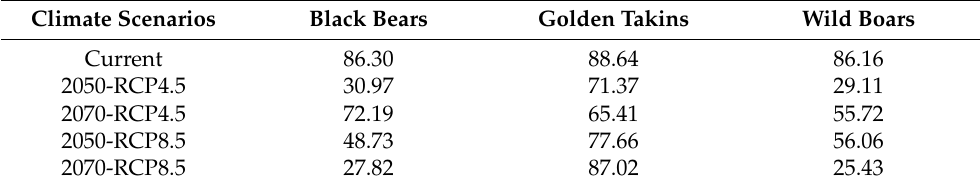
Table 4. Statistics on overlapping area of suitable habitats between giant pandas and sympatric